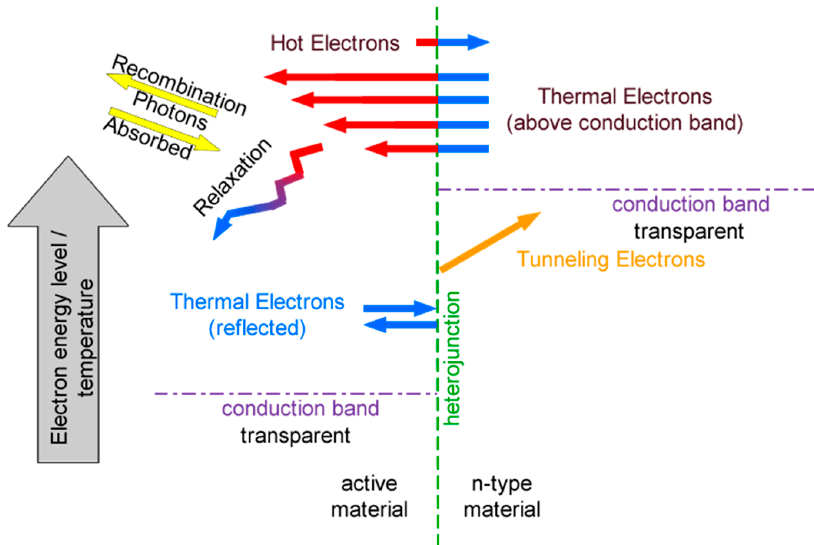
Figure 8. Relevant Paths for Electrons at the n-type heterojunction of a LED. Note that electrons crossing right to left will initially be at least (delta)E g above the conduction band (‘Hot Electrons’) and will relax down toward a Fermi-Dirac distribution through collisions.